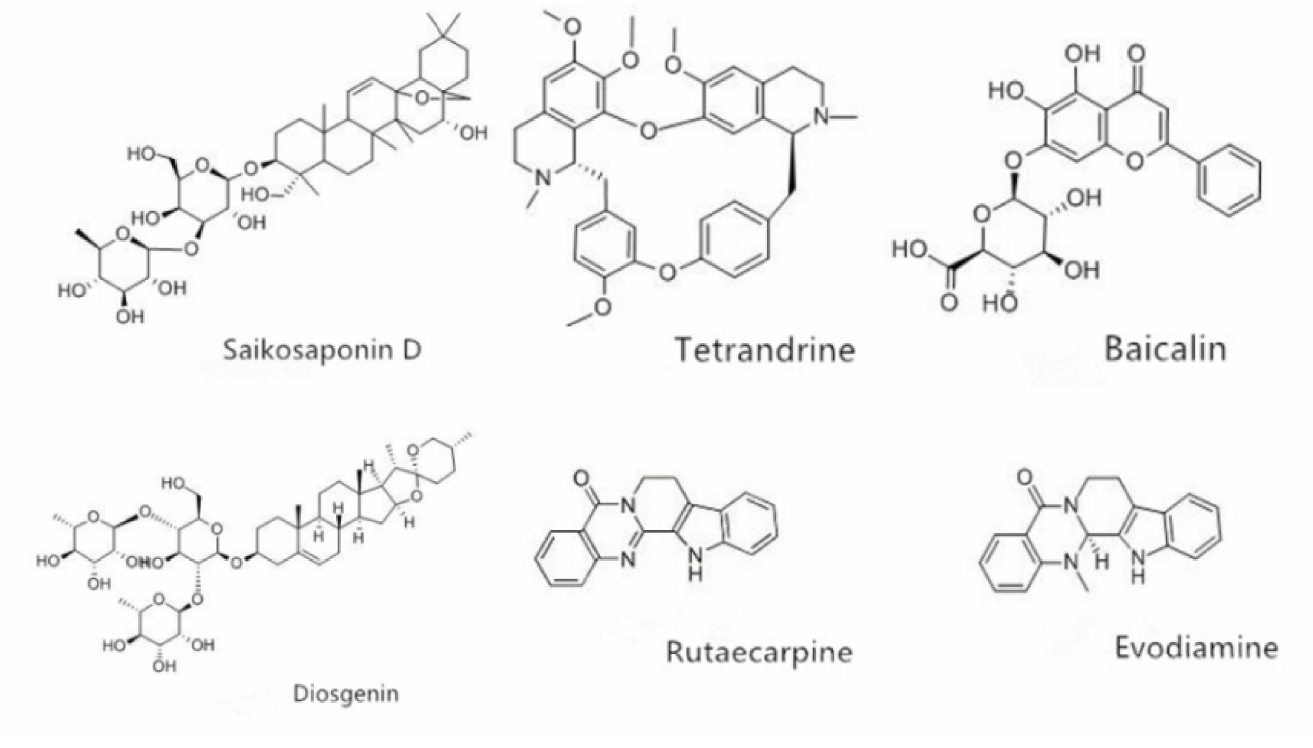
Fig 4. The structure of 6 compounds with strong binding capacity for p38.